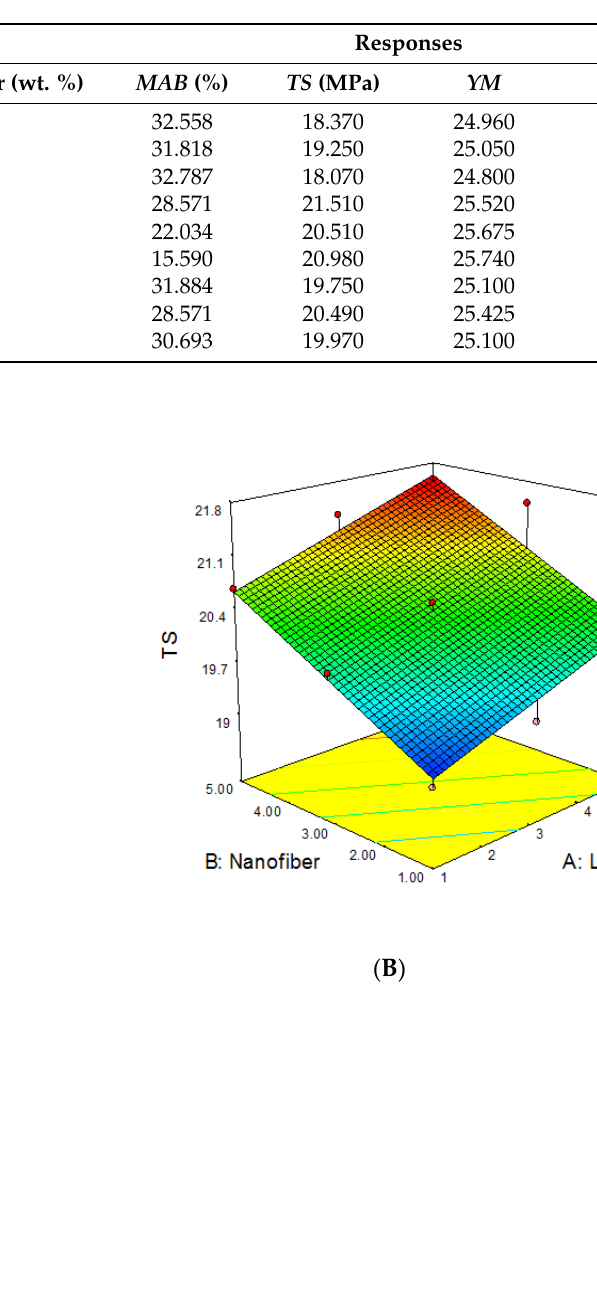
Table 6. RSM factorial design matrix for lignin–cellulose nanofiber-filled thermoplastic starch com- posite